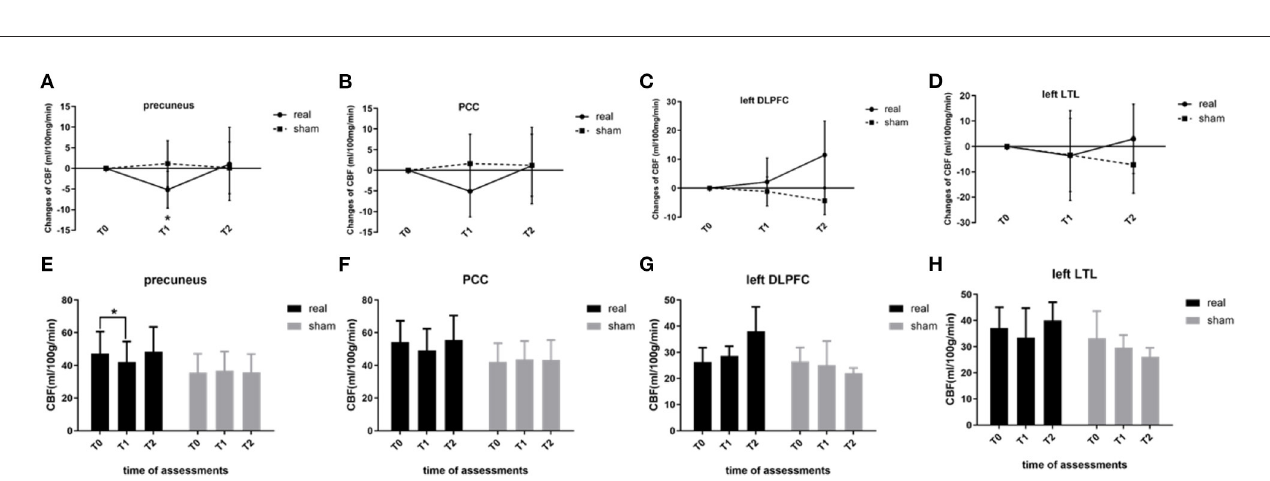
FIGURE2 Regional CBF changes at the ROI level. (A) Precuneus, (B) PCC, (C) left DLPFC, and (D) left LTL. (E–H) show regional CBF within the two groups (real and sham) at three timepoints (T0, T1, T2). CBF, cerebral blood flow; ROI, region-of-interest; PCC, posterior cingulate cortex; DLPFC, dorsal lateral prefrontal cortex; LTL, lateral temporal lobe. * p < 0.05. Error bars indicate